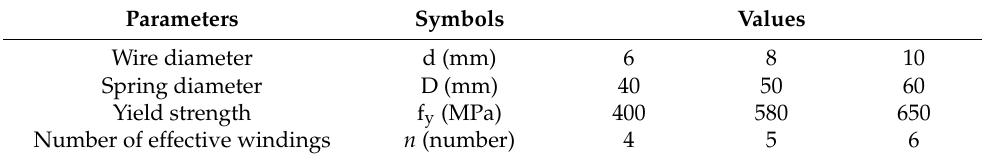
Table 1. Design parameters of SCD.